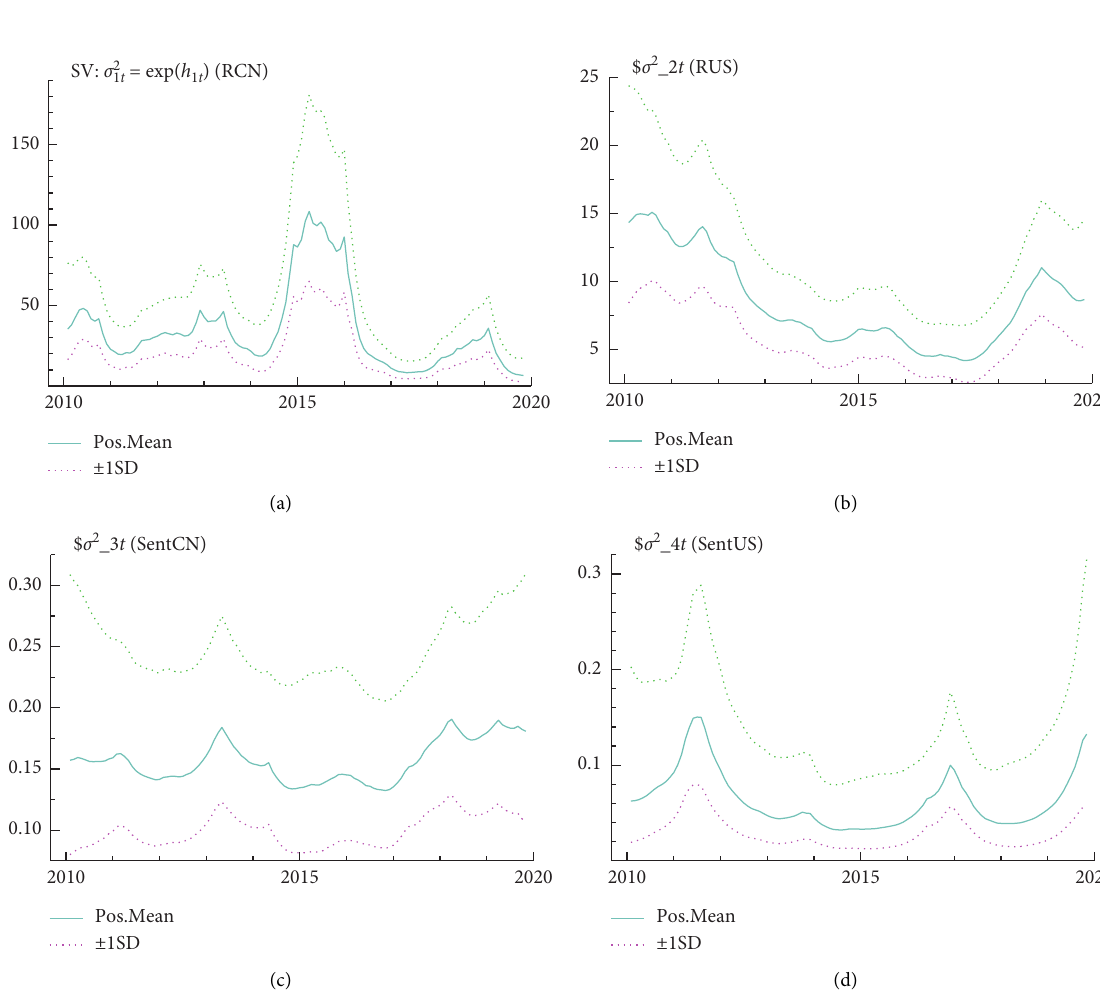
Figure 5: Posterior estimates for stochastic volatility of structural